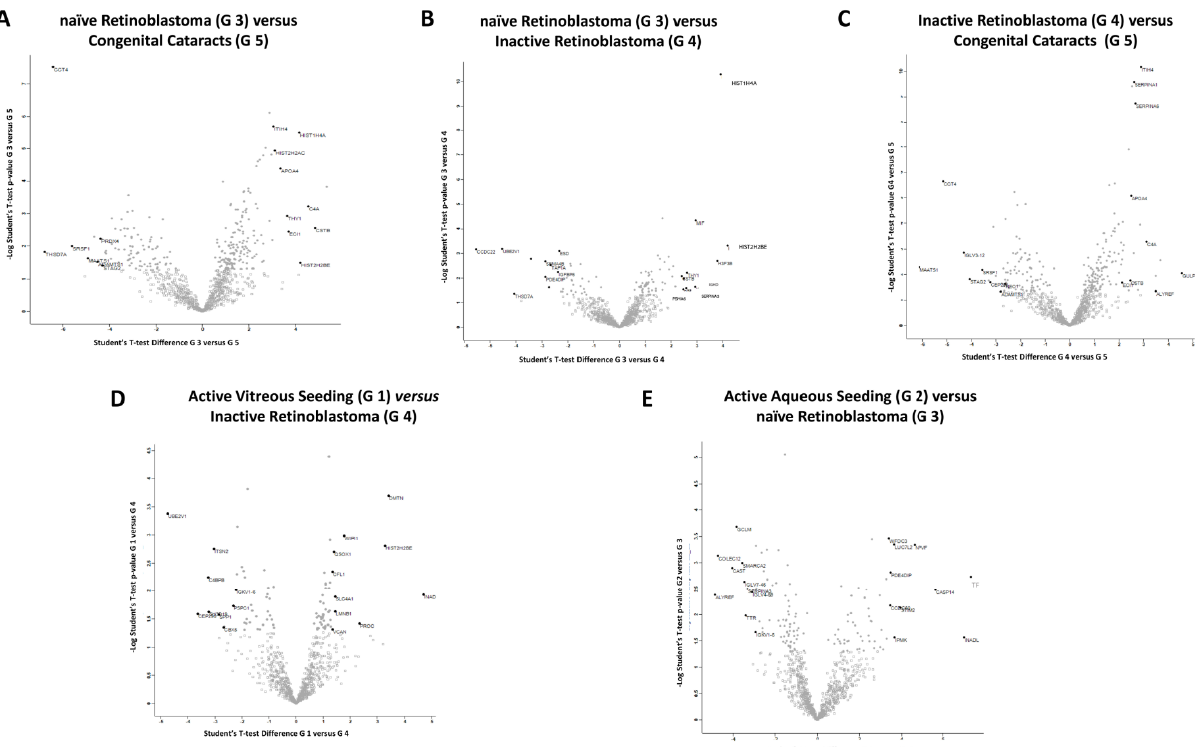
Figure 2. Volcano plots showing abundance of differentially expressed proteins between two of the five groups at a time: ( A ) naïve RB compared to congenital cataracts; ( B ) naïve RB compared to inactive RB; ( C ) inactive RB compared to congenital cataracts; ( D ) active vitreous seeding compared to inactive RB; ( E ) active aqueous seeding compared to naïve RB. The black line shows p value = 0.05 and s0 = 0.1. Red dots depict proteins whose fold change is <2 (log2 = 1) or p > 0.05 between the two groups